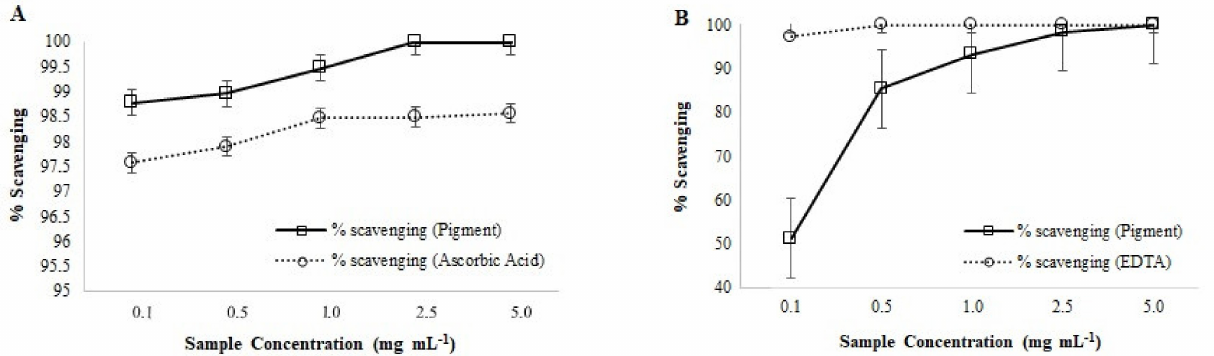
Figure 10. Dose-dependent antioxidant activities of the pyomelanin-like compound produced by B. haynesii CamB6; where ( A ) hydroxyl radicals ( • OH) scavenging effects, and ( B ) ferrous (Fe 2+ ) chelating